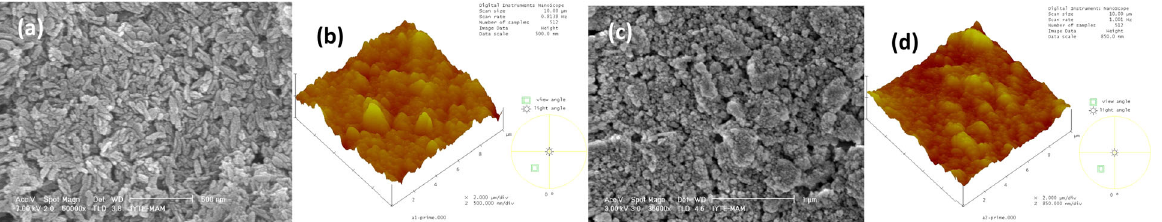
Fig. 6 The SEM and AFM images of the c-HAp and m-HAp fi lms (with 15w% solid content suspension) on the glass/ fi broin substrate ( a ) the SEM image of c-HAp fi lm, 50,000x, ( b ) the AFM 3-dim.